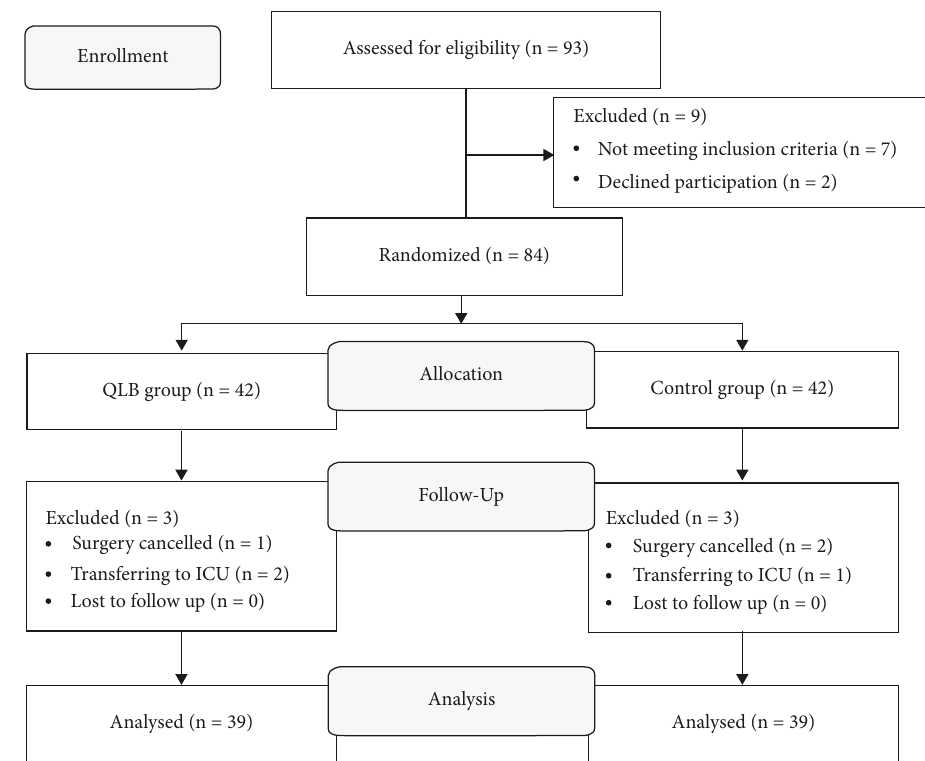
Figure 1: CONSORT flow diagram. QLB: quadratus lumborum block. Table 1: Demographic, psychological, and clinical characteristics of the